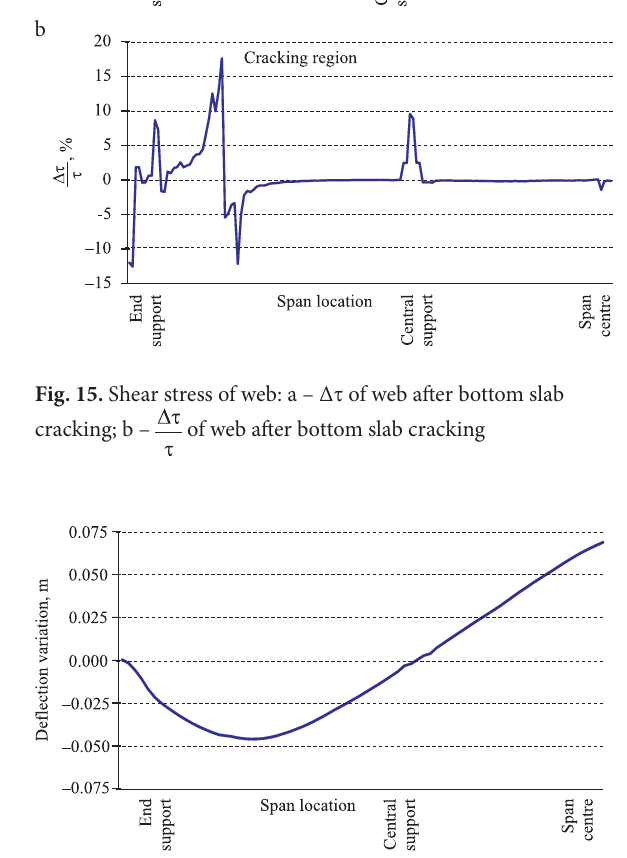
Fig. 16. The deflection variation of box girder after bottom slab